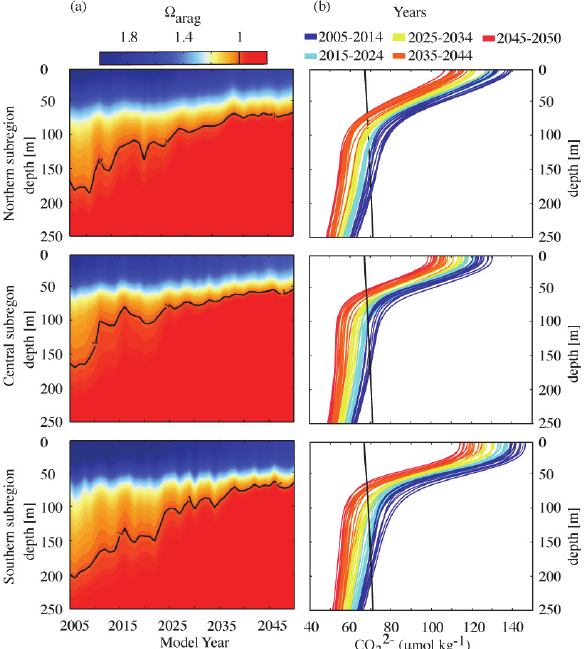
Fig. 15. (a) Evolution of the depth of aragonite saturation horizon as a function of time and depth. The depth of the saturation horizon is depicted as a black line. Panel (b) shows the expected shifts in the [CO 2 − 3 ] profiles for the years 2005–2050. The black line indicates the depth of the saturation horizon as a function of [CO 2 − 3 ] and depth.